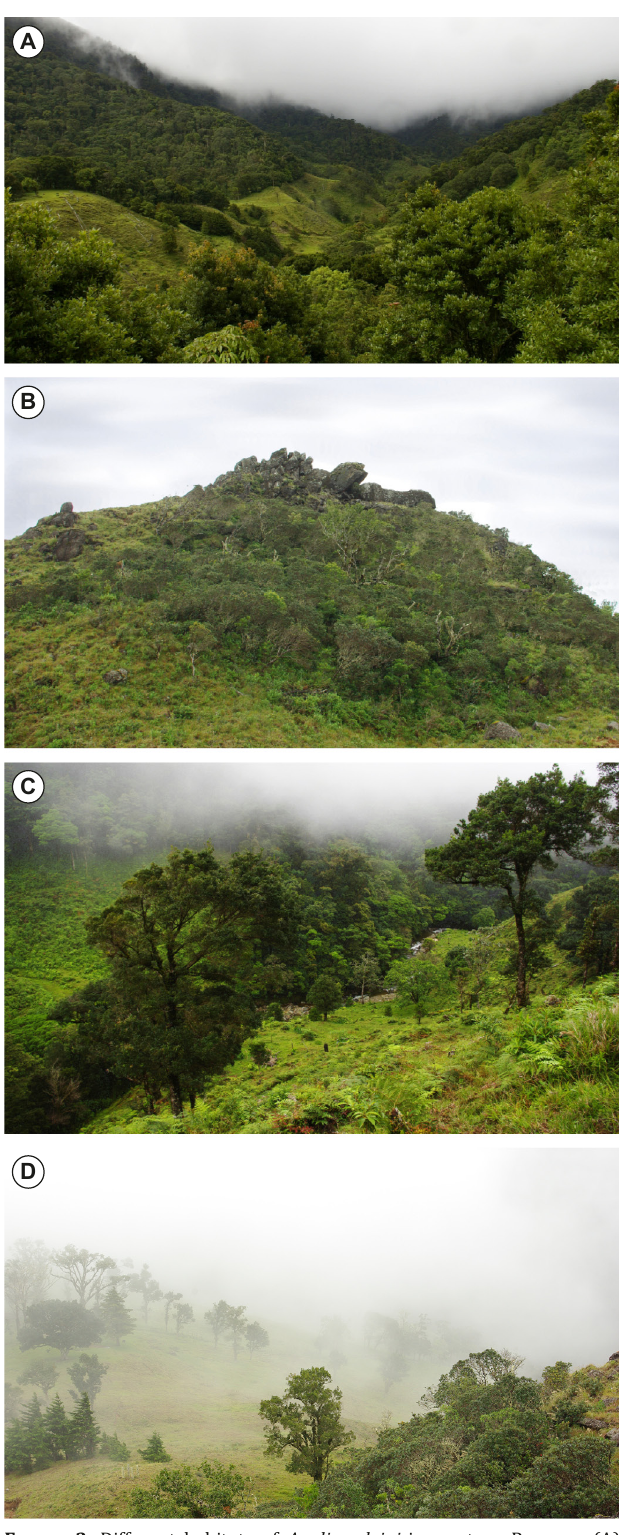
Anolis salvini Figure 3. Different habitats of in western Panama: (A) mosaic of pasture and forest at Jurutungo, ca. 2000 m asl; (B) isolated patch of elfin forest at Alto Jaramillo, ca. 2050 m asl; (C) pasture at Quebrada Juglí, ca. 1700 m asl; (D) agricultural area at Alto Jaramillo, ca. 2000 m